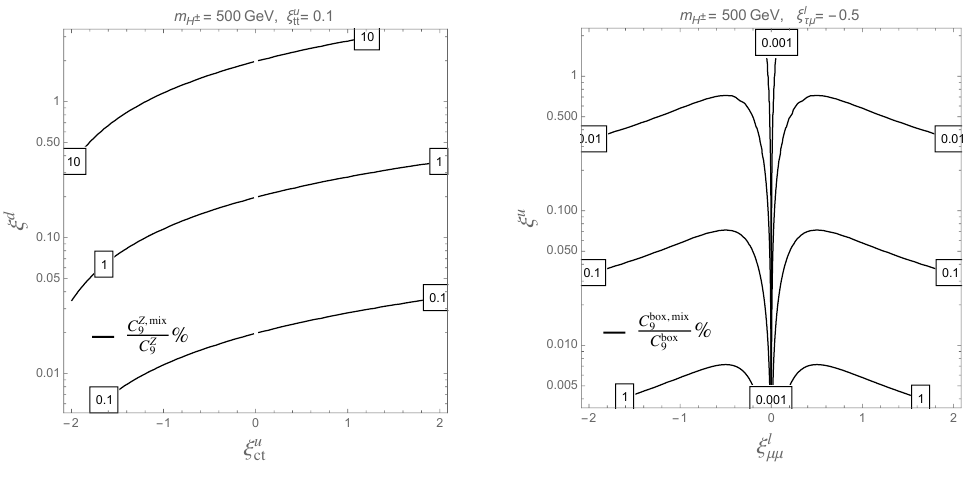
Figure 3 . Left: C Z, mix /C Z contour levels for ξ d 9 9 and second terms in eq. (3.11) respectively. Right: C box , mix C box and C box , mix refers to the first and second terms in eq. (3.12) 9 9